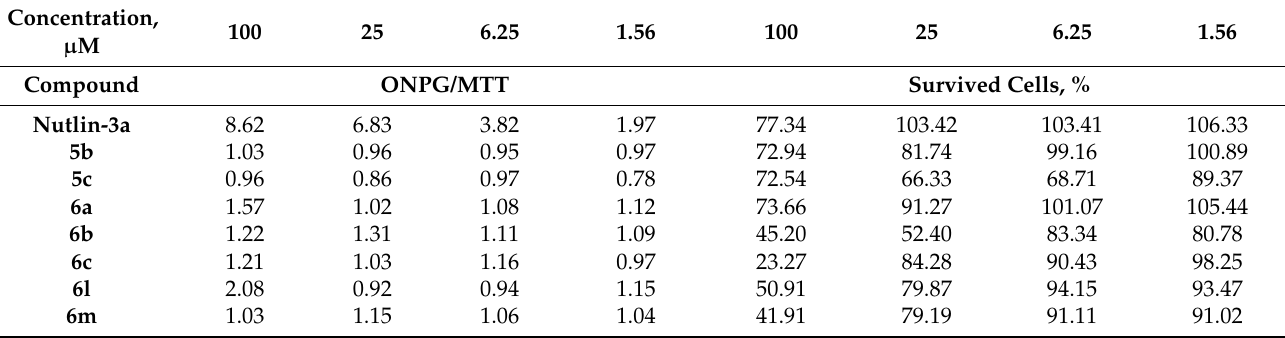
Table 2. p53 reporter activation test at the A549 cell line for some compounds of 5 and 6 . The “ONPG/MTT” columns indicate values of p53 activation normalized to the number of surviving cells (ONPG = ortho-Nitrophenyl-ß-galactoside). The ONPG/MTT parameter value ≥ 2 may indicate p53 activation